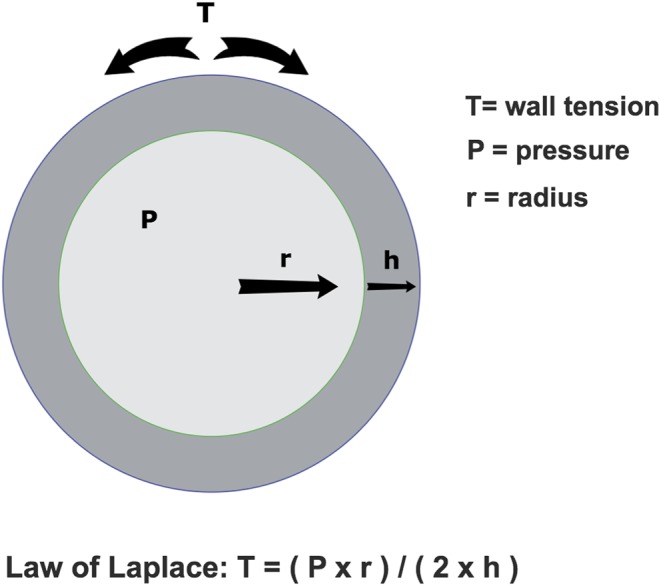
This figure shows the law of Laplace applied to a cross-sectional diagram of LV. The law of Laplace dictates that the LV wall tension is directly proportional to the product of the LV pressure and the LV radius. The LV wall tension is also inversely proportional to the LV wall thickness. LV, left ventricle.